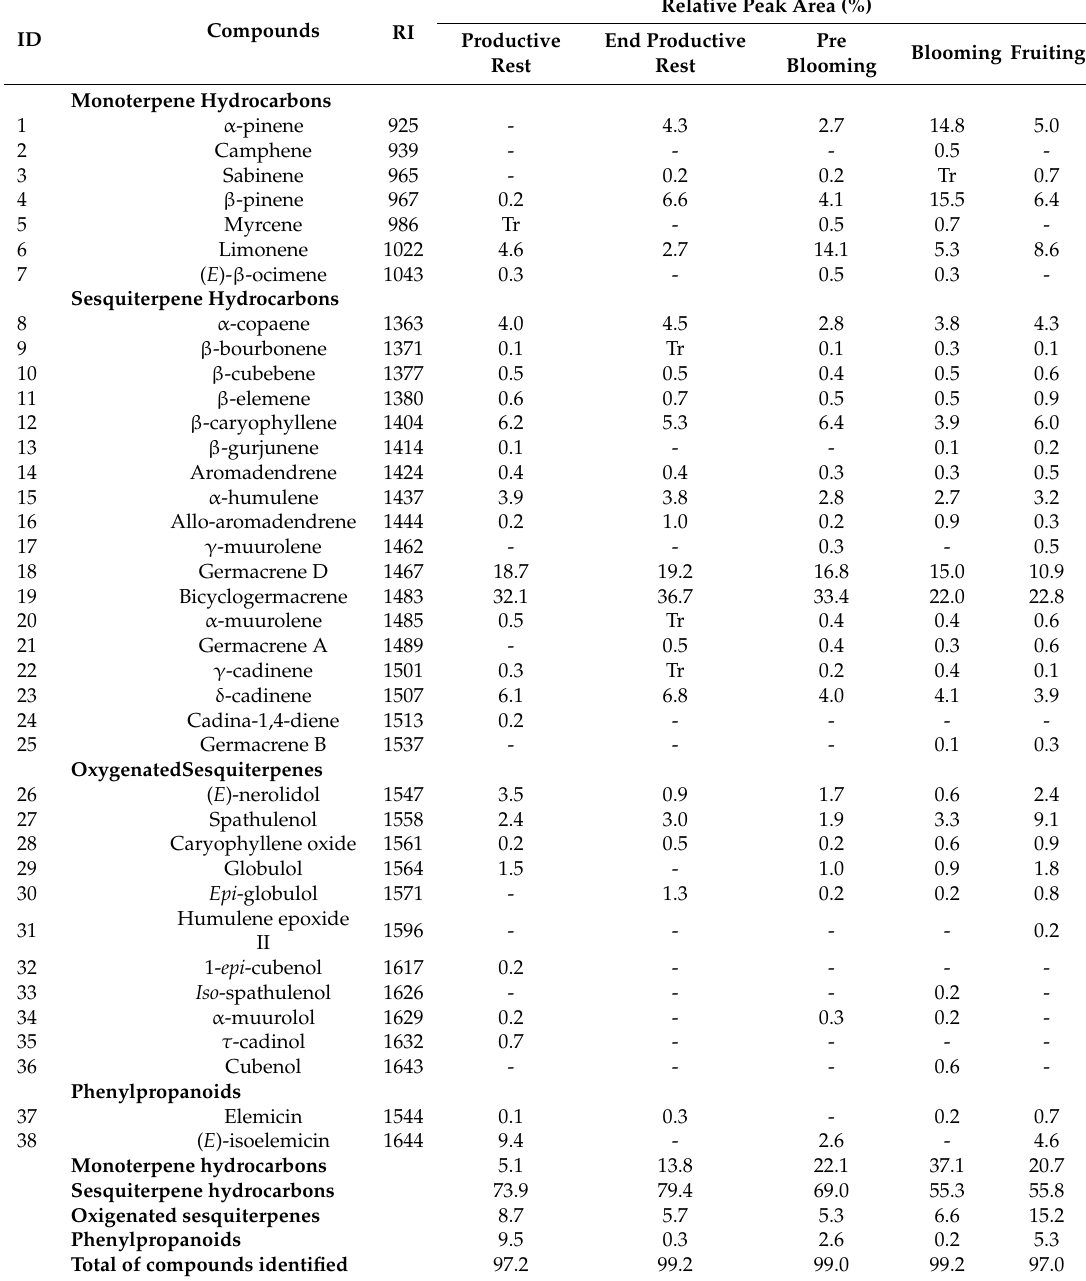
Table 2. Variability in the chemical composition of essential oils obtained from leaves of Nectandra megapotamica collected during different developmental phases of the